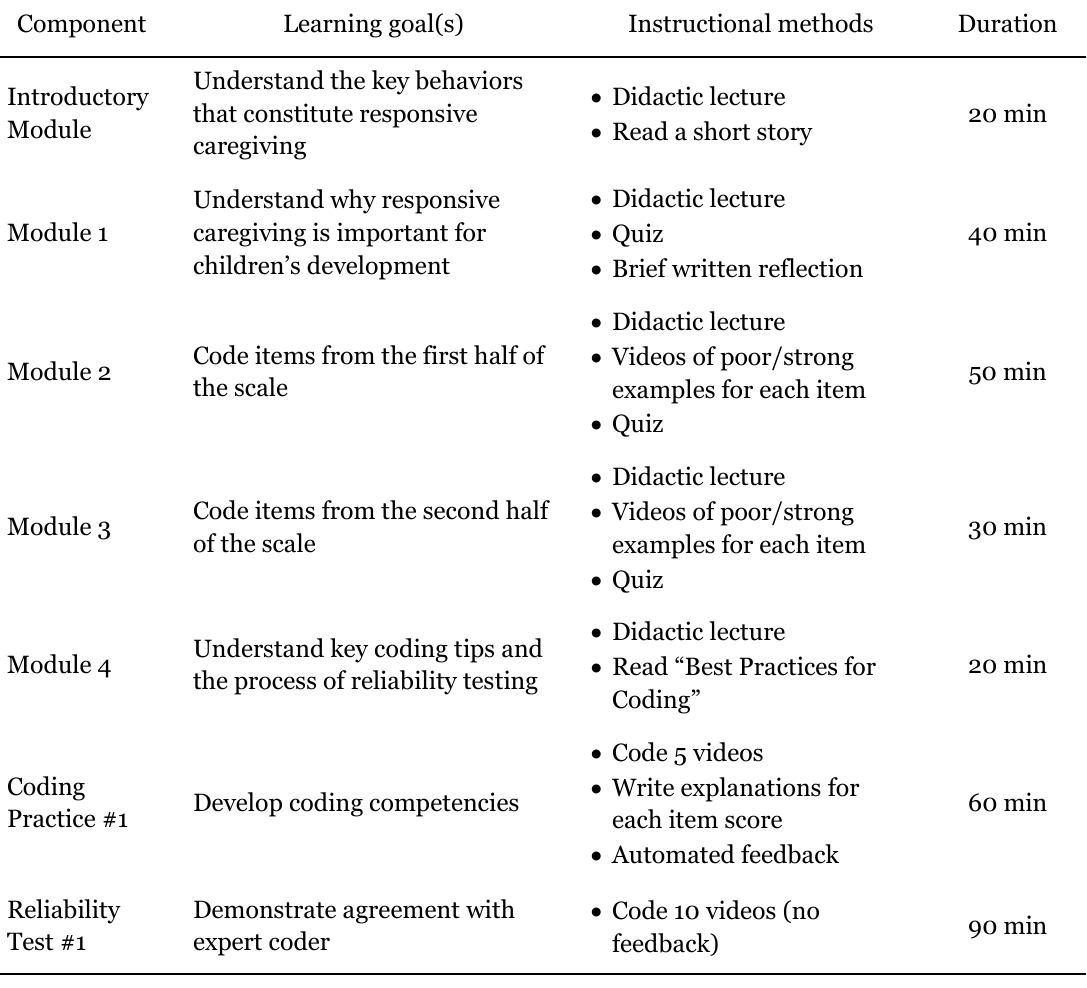
Table 1 Outline of Course